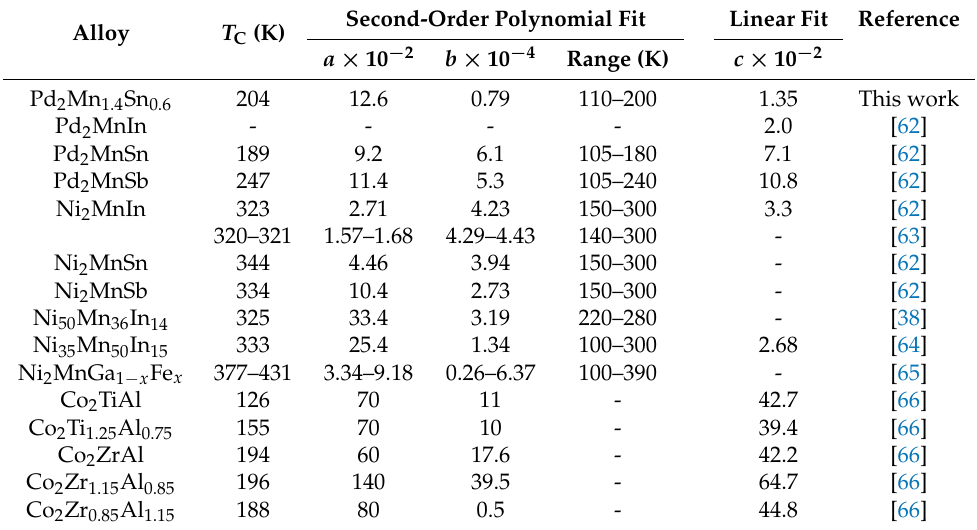
Table 1. Curie temperature T C , fitting parameters a , b , and the fitting range obtained by use of Equation (1), and c by use of Equation (2) for the Pd 2 Mn 1.4 Sn 0.6 alloy. Earlier reports for other Pd-, Ni-, and Co-based stoichiometric and non-stoichiometric Heusler alloys are listed for comparison. Alloy T C